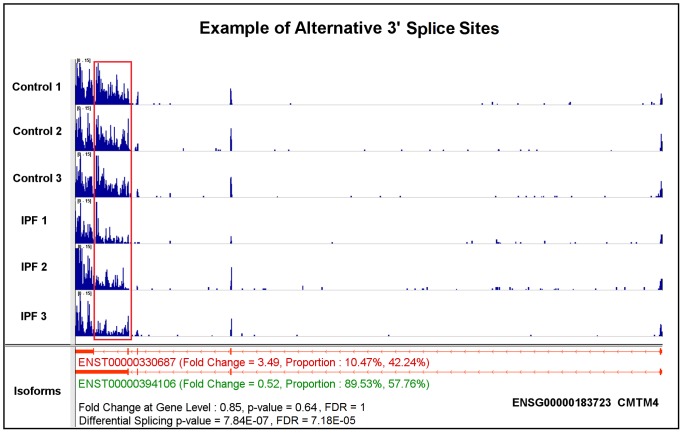
A case study of gene CMTM4 highlighting the alternative 3′ acceptor site splicing mechanism using the annotated transcripts.